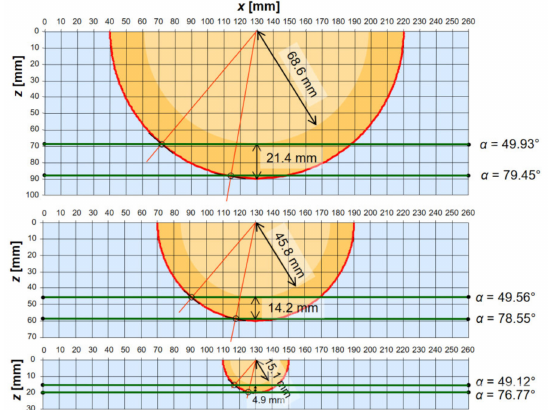
Figure 14. Visualization of results of calculations of the area of the largest ultrasound wave refrac- tions in the breast section for 3 different diameters of these sections ( D b = 180, 120, 40 mm) in the horizontal plane.